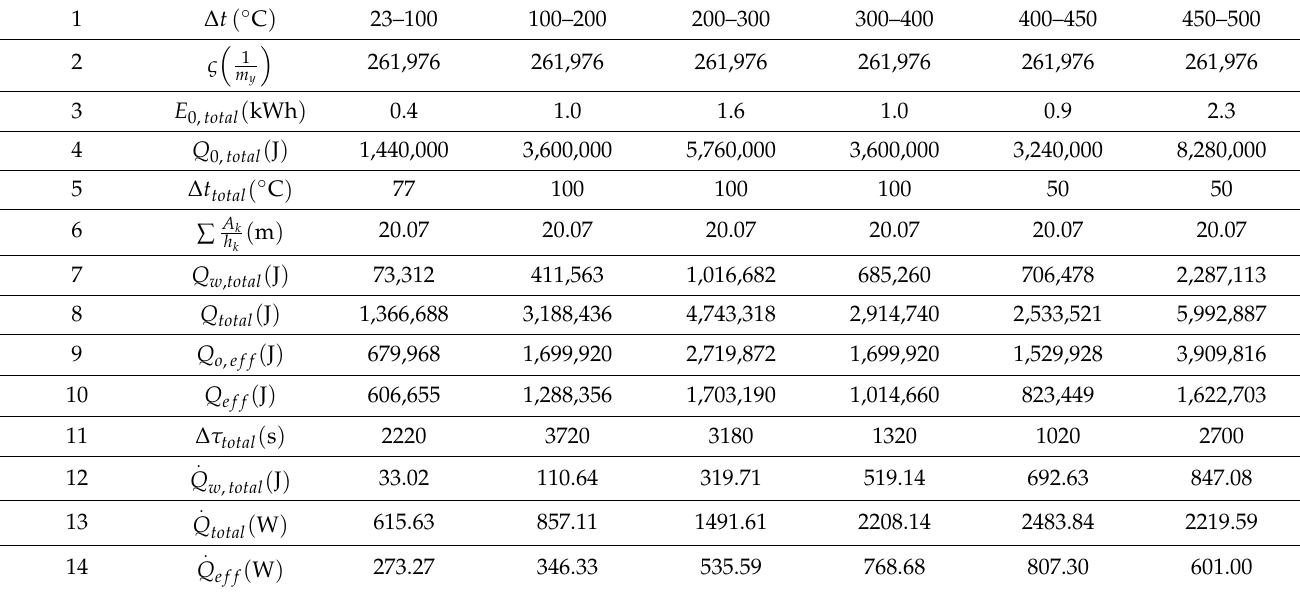
Table 4. Small model, painted—scale 1:4; values of the dependent variables by the